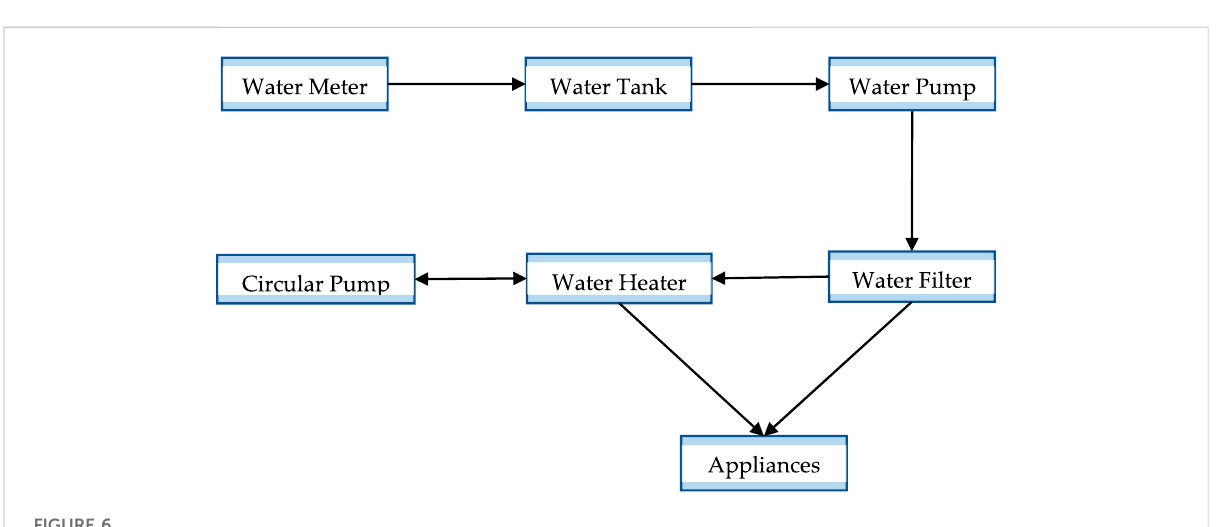
FIGURE 5 Annual rainfall in Kuwait in mm (World Bank,